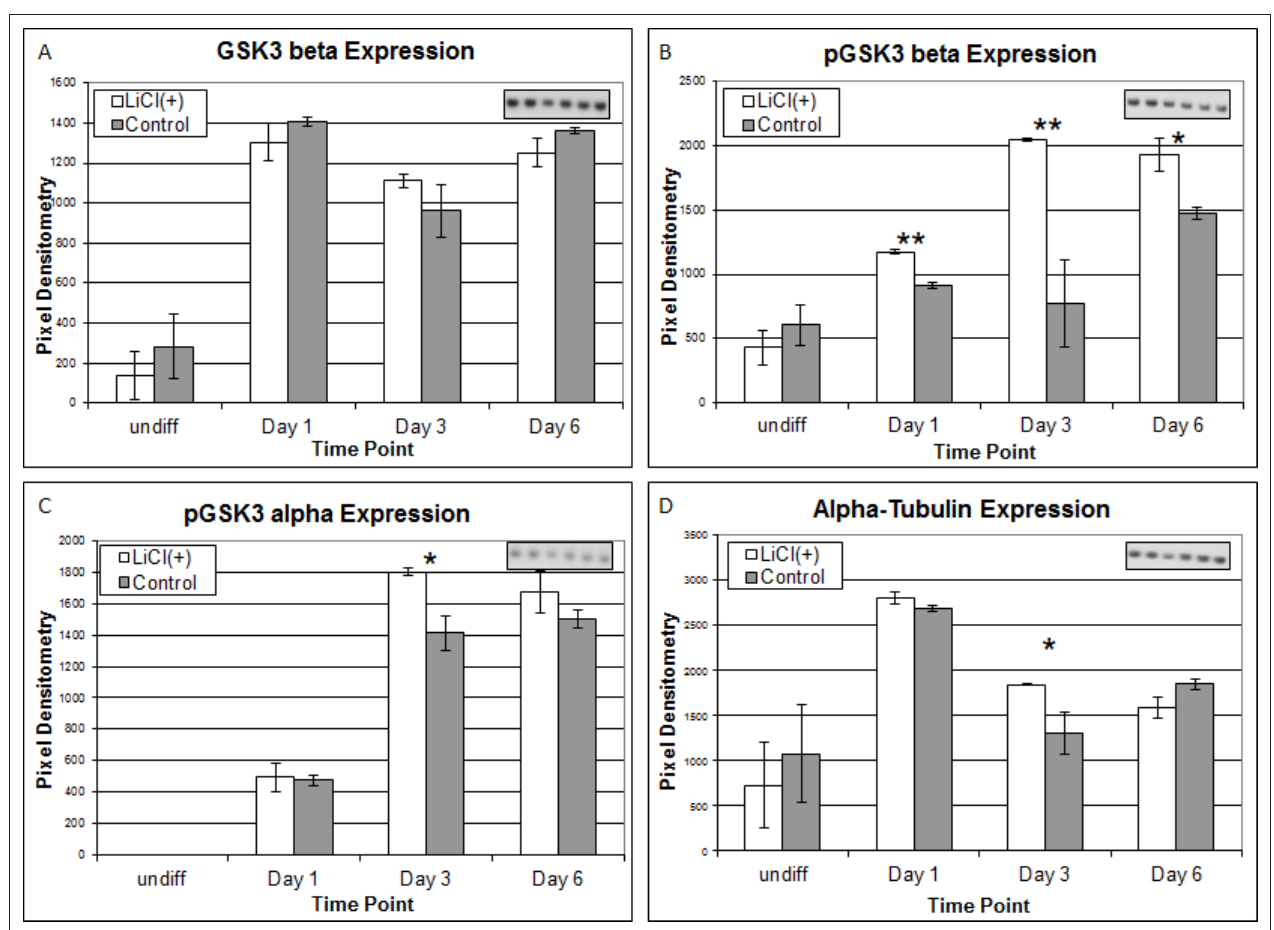
Figure 3 | Expression of total GSK3- β (a) , pGSK3- β (B) , pGSK2- α (c) and α -Tubulin (D) proteins following LiCl treatment, at various time points of differentiation ( n = 3). Inset images representative of western blot raw data. Error bars represent